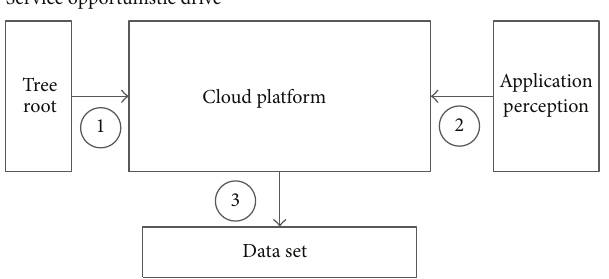
Figure 4: Service driven tree.